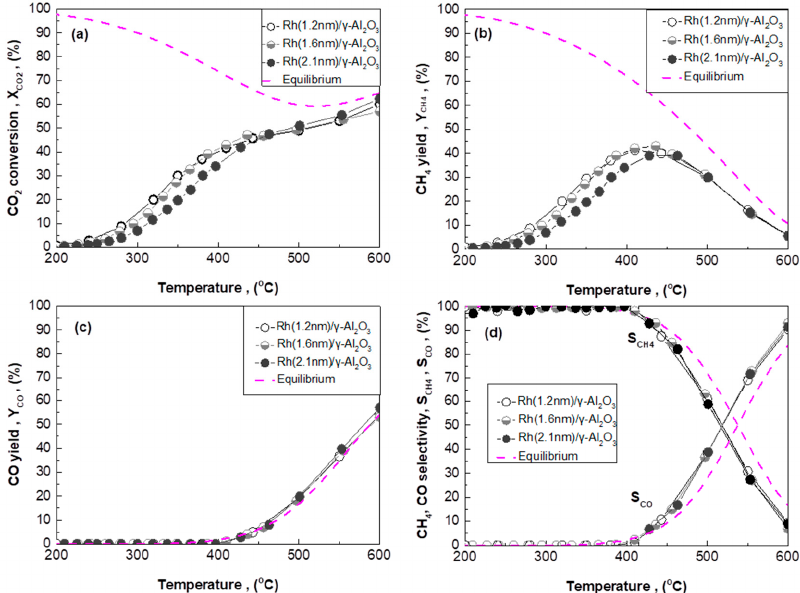
Figure 5. CO 2 hydrogenation performance ( X CO2 ( a ), Y CH4 ( b ), Y CO ( c ), S CH4 and S CO ( d )) of Rh(1.2nm) / γ -Al 2 O 3 , Rh(1.6nm) / γ -Al 2 O 3 , and Rh(2.1nm) / γ -Al 2 O 3 catalysts under integral reaction conditions. Experimental conditions: feed composition of 5% CO 2 / 20% H 2 / 75% Ar at 1 bar; mass of catalyst m cat = 50 mg; fixed mean contact time of CO 2 at τ (CO 2 )~1.3 s, corresponding to wGHSV values of 120,000, 93,600, and 70,800 N mL / g · h for the Rh(1.2nm), Rh(1.6nm), and Rh(2.1nm) / γ -Al 2 O 3 catalysts, respectively.